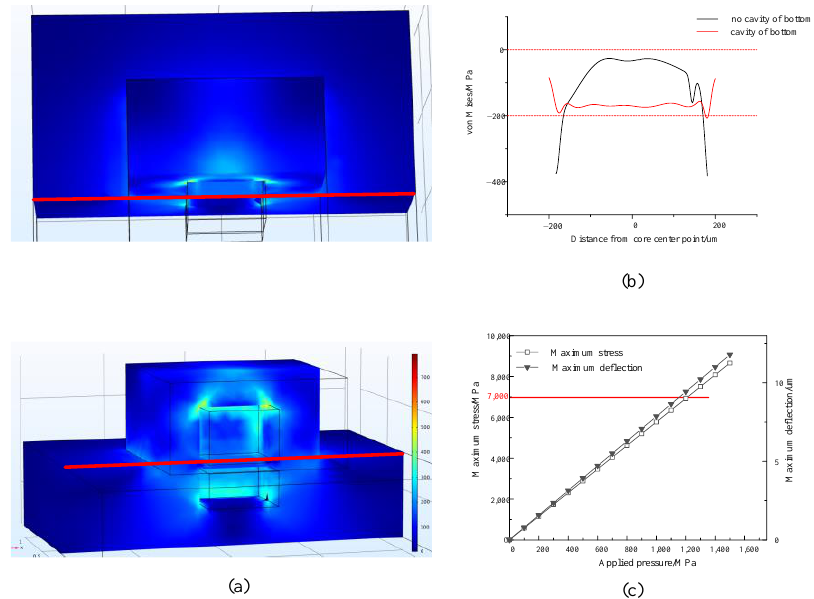
Figure 4. ( a ) Simulation model of the bottomless cavity and bottomed cavity structure. ( b ) The equivalent stress distribution along the centerline of the base surface (the piezoresistive doped area is in the upper cavity). Except for the cavity, the two models have the same structure size, the externally applied hydrostatic pressure is 200 MPa, and the elastic modulus E is 1.69 × 10 11 Pa. ( c ) Relationship between the external load of the CCSB structure and the maximum stress and displacement of the sensor.